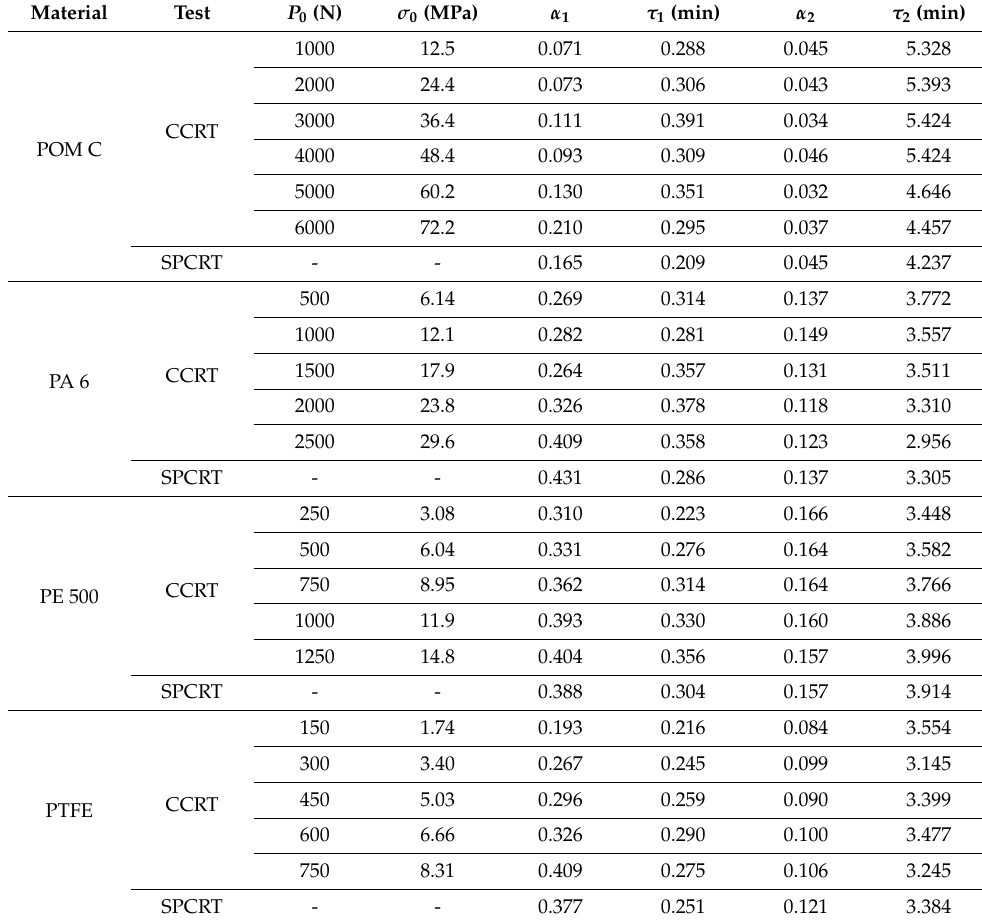
Table 4. Coefficients of Prony series for the evaluated